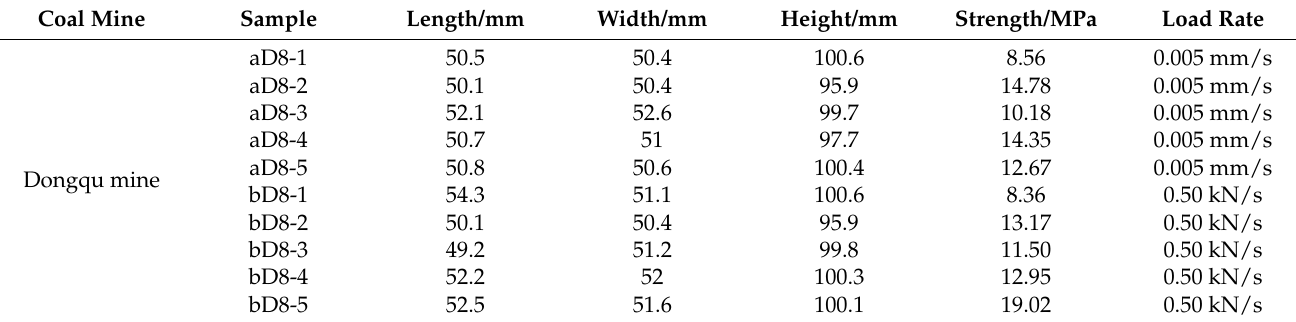
Table 2. Coal sample numbering grouping.